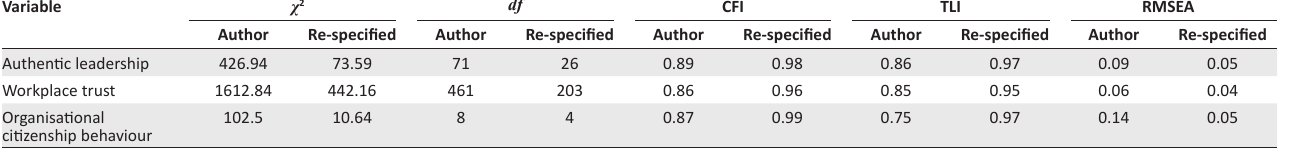
TABLE 1: Changes in the fit statistics in confirmatory factor analyses of authentic leadership, workplace trust and organisational citizenship behaviour.